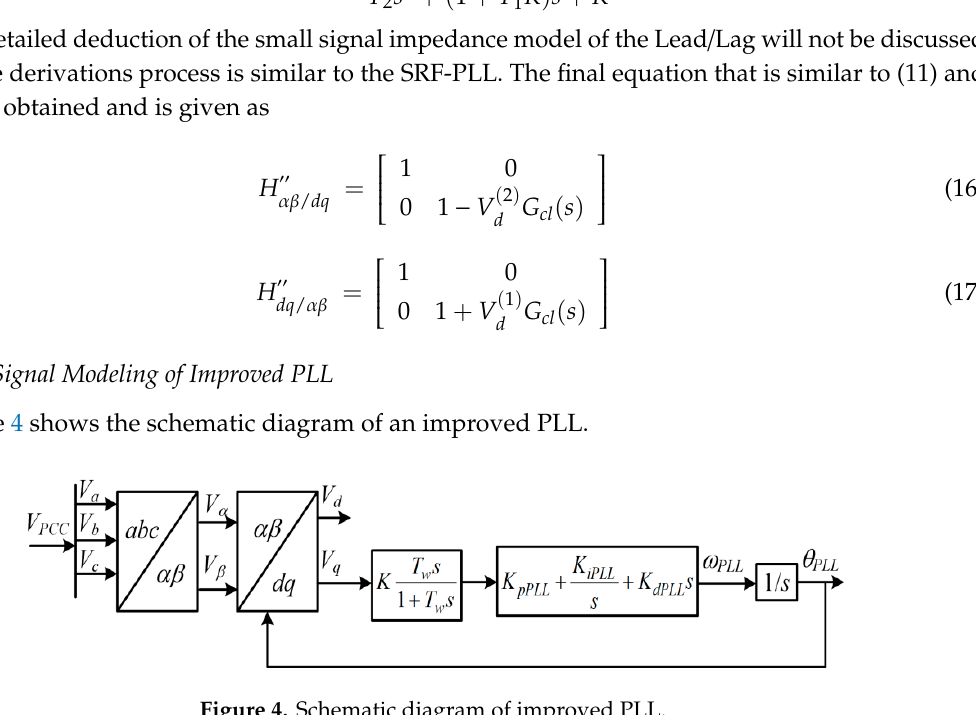
Figure 3. Schematic diagram of Lead/Lag PLL.